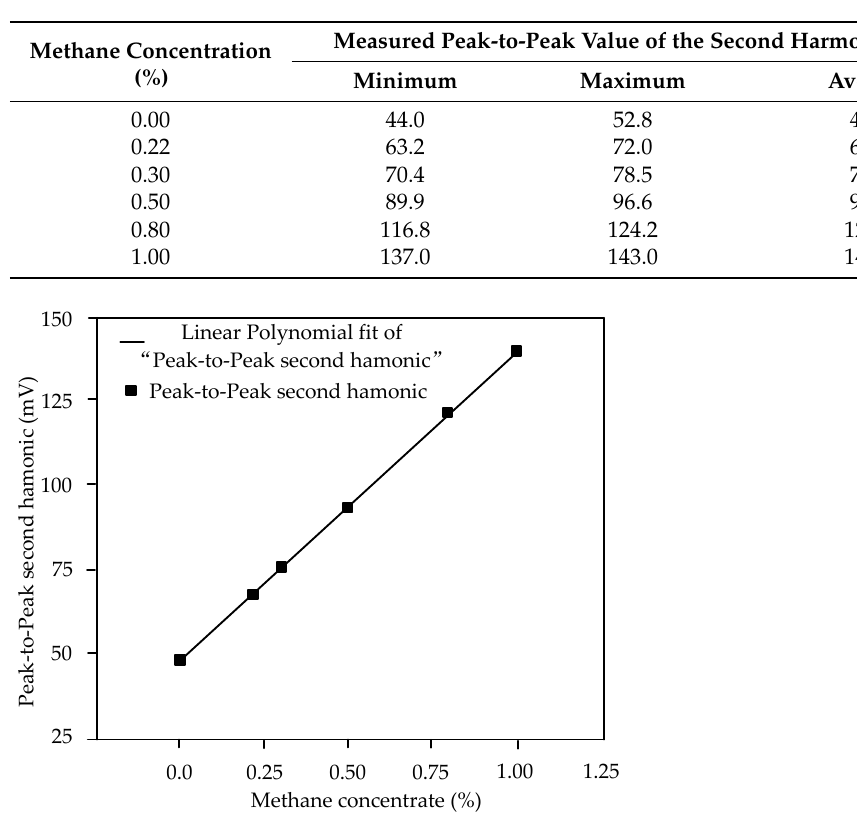
Figure 5. Relationship between peak-to-peak average values of second harmonic detection and me-